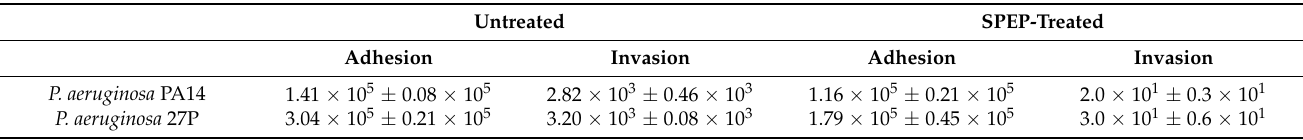
Table 1. Adhesion and invasion abilities of P. aeruginosa on A549 cells in the presence and in the absence of SPEP.